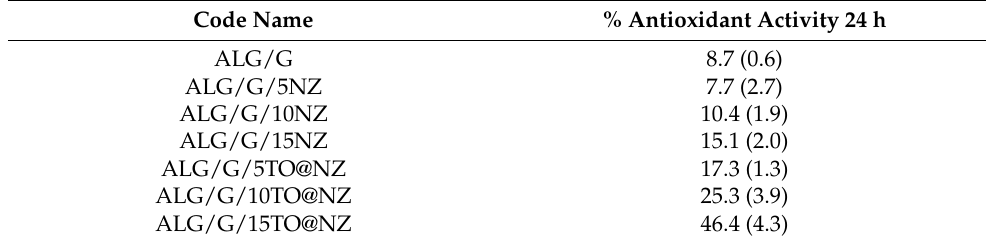
Table 3. Antioxidant activity of all obtained films.